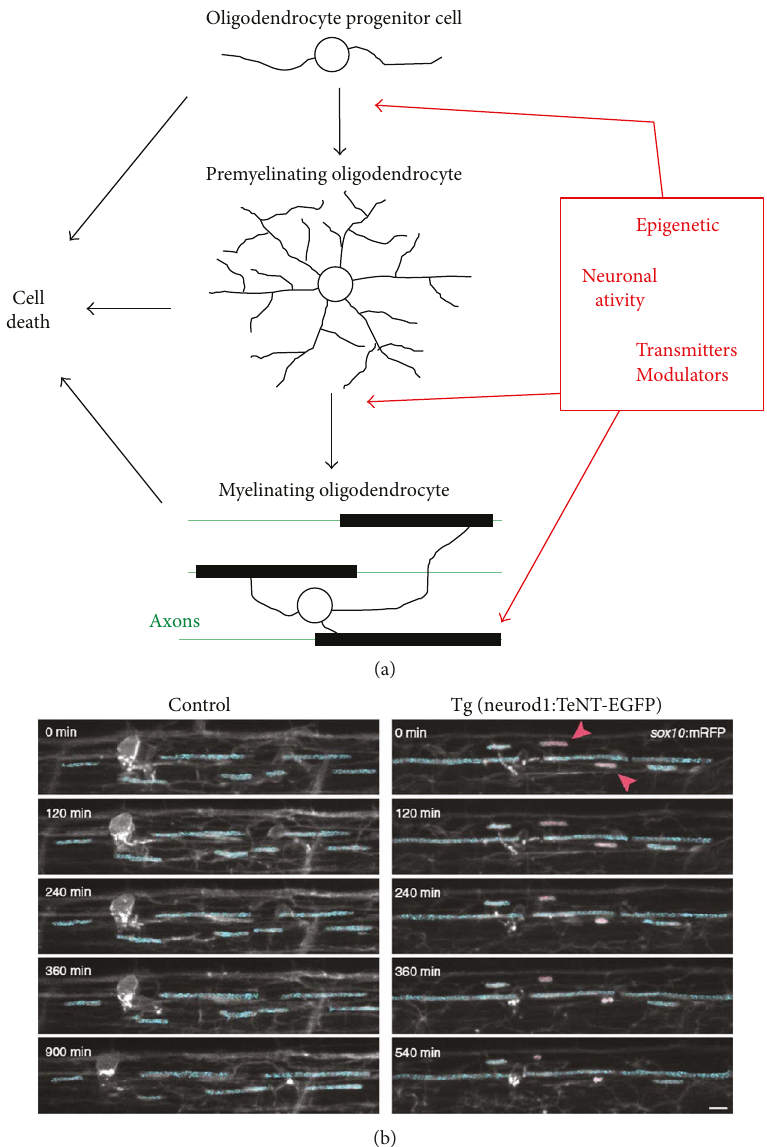
Figure 3: Mechanisms underlying activity-dependent regulation of myelination. (a) Diagram of the multiple steps involved in the development of OLs. OPCs di ff erentiate into multipolar premyelinating OLs, which mature into myelinating OLs. Mature OLs form myelin segments on multiple axons simultaneously. Regulation can occur at di ff erent steps during development, eventually leading to altered myelin formation. (b) Nascent myelin sheaths are stabilized by activity-dependent secretion. Representative confocal images show the retraction of existing sheaths during 15h time-lapse imaging in sibling control (left) and Tg(neurod1:TeNT-EGFP) larvae (right). In the right panel, expression of TeNT-EGFP disrupted axonal activity-dependent secretion. Images are lateral views of the dorsal spinal cord, and the time relative to the start of image acquisition is indicated for each image. For demonstrative purposes, sheaths stable for the entire time-lapse are shaded in blue. Retracting sheaths are shaded in red and are also indicated by red arrowheads (modi fi ed from Hines et al. [71], with copyright permission for reusing the fi gure panels). Scale bar: 5 μ